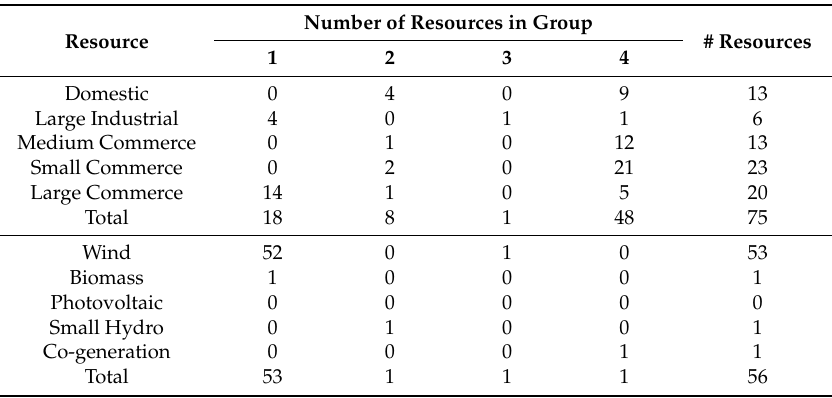
Table 4. Aggregation of resources—Period 20 | K =